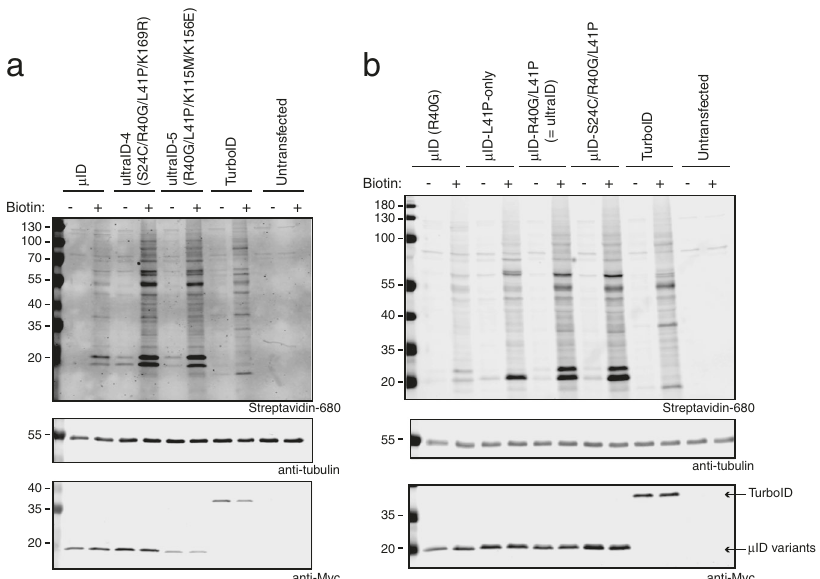
Fig. 4 ultraID variants show improved activity compared to microID. Blots of lysates of HeLa cells transiently transfected with the indicated constructs and incubated with 50 μ M biotin for 10 min. Biotinylation was analyzed using IRDye680-labeled streptavidin and expression levels of the fusion proteins with antibodies against the Myc tag as indicated. a Comparison microID, ultraID-4 and -5, and TurboID. b Comparison microID, microID